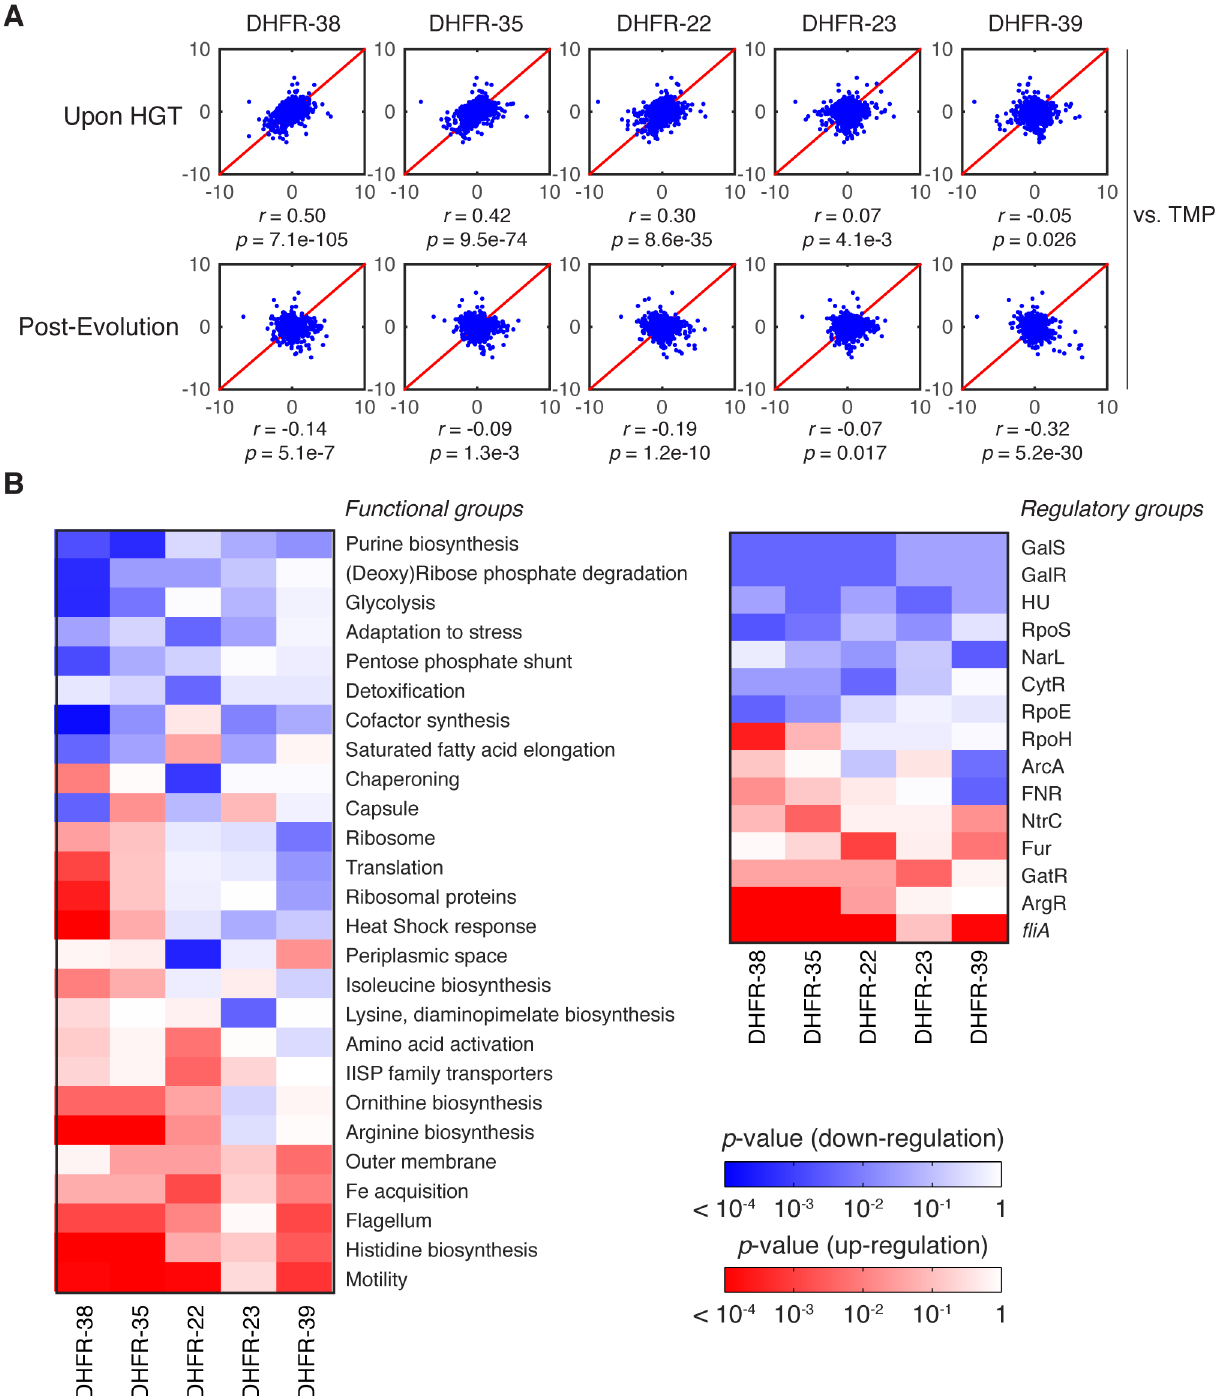
Fig 7. Global proteomic response to HGT. A) z-scores correlation plots between proteomes of indicated DHFR orthologous strains (upon HGT and after evolution) and WT strain treated with 1 μ g/ml trimethoprim (TMP) (see Materials and Methods and S6 Table). The strains are representative of the fitness effects upon HGT: DHFR-23, 35 and 38 are severely deleterious; DHFR-22 is mildly deleterious; and DHFR-39 is beneficial (Fig 1C). Global proteome quantification was obtained using LC-MS/MS analysis of TMT-labeled proteomes [34]. Each quantified protein (+2,000 proteins per proteome) is assigned a z-score that measures the enrichment of its abundance relative to the whole proteome (see Materials and Methods). The proteome profile upon HGT of DHFR-38, 35 and 22 is similar to the adverse cellular state during the antibiotic treatment, but is relaxed after experimental evolution. The strains are ordered left to right according to decreasing similarity with TMP treated WT cells (top panel). B) Change in global variation in protein abundances induced